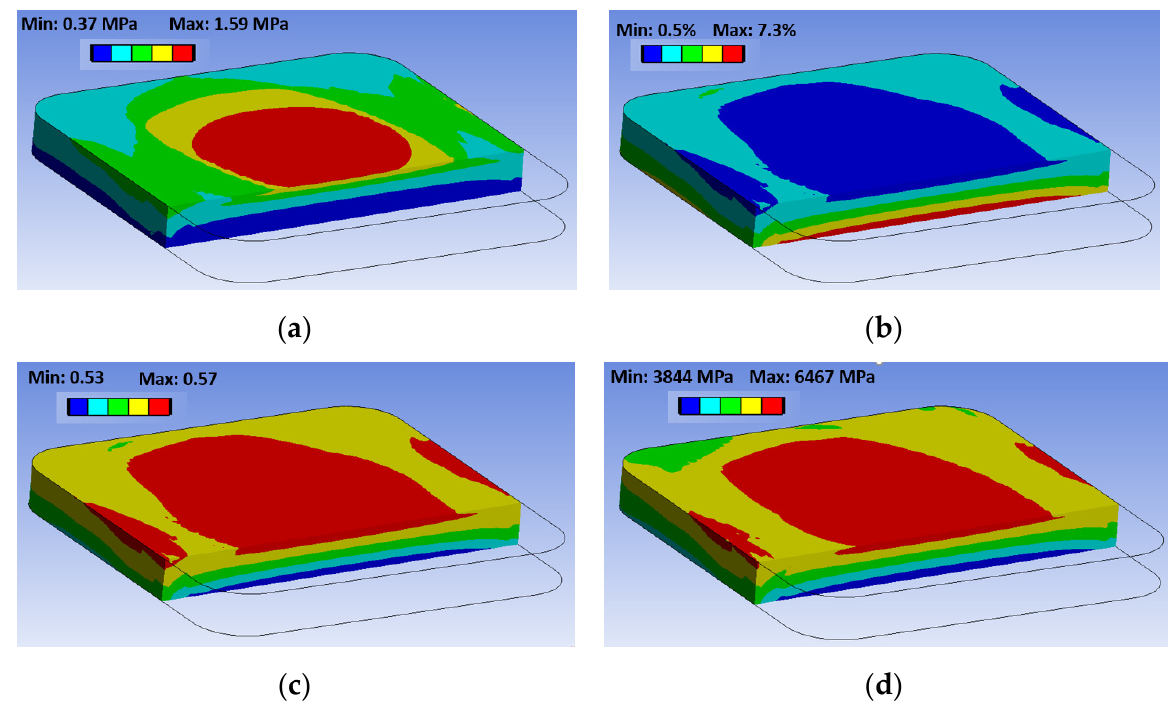
Figure 20. Final void pressure ( a ), porosity ( b ), fiber volume content ( c ), and elastic modulus in the transverse to fiber direction ( d ) in sample B (2 MPa, 175 °C).